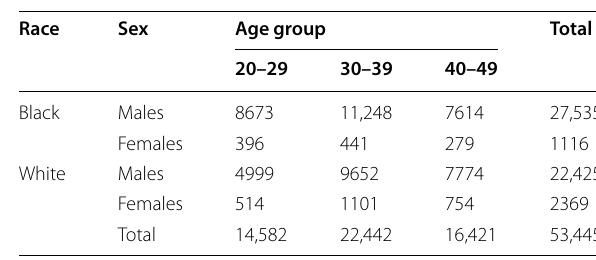
Table 1 Frequencies of mugshots used, as a function of